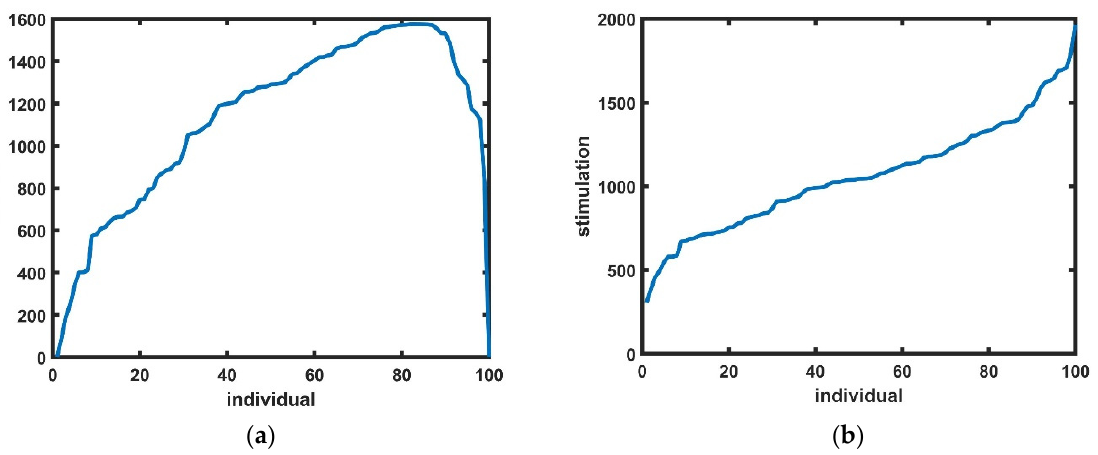
Figure 1. Comparison of stimulations. ( a ) The stimulations of AIAGS. ( b ) The stimulations of other algorithms.